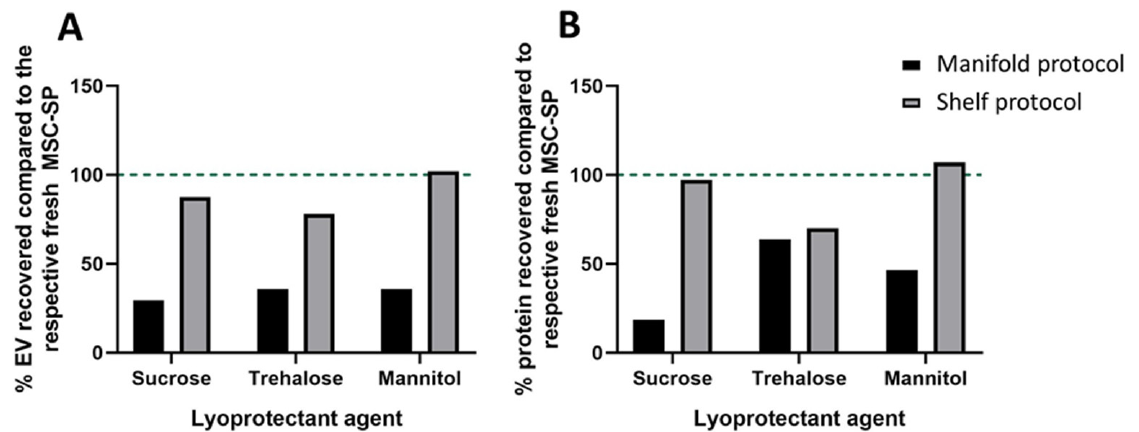
Figure 3. Comparison of the structural characteristics of freeze-dried MSC-SP prepared using two different lyophilization methods. The MSC-SP were isolated by tangential flow filtration using three different diafiltration agents, 5% w/v sucrose, 4% w/v trehalose and 4% w/v mannitol. The MSC-SP were subsequently separated into equal volume aliquots. Two aliquots of each sample were lyophilized using either a manifold- or a shelf-based protocol, and the third aliquot was stored at 4 ◦ C. The lyophilized MSC-SP were reconstituted, and the EV and protein constituents were quantified by nanoparticle tracking analysis and BCA assay, respectively. The ( A ) EV and ( B ) protein recoveries in the lyophilized MSC-SP were calculated.